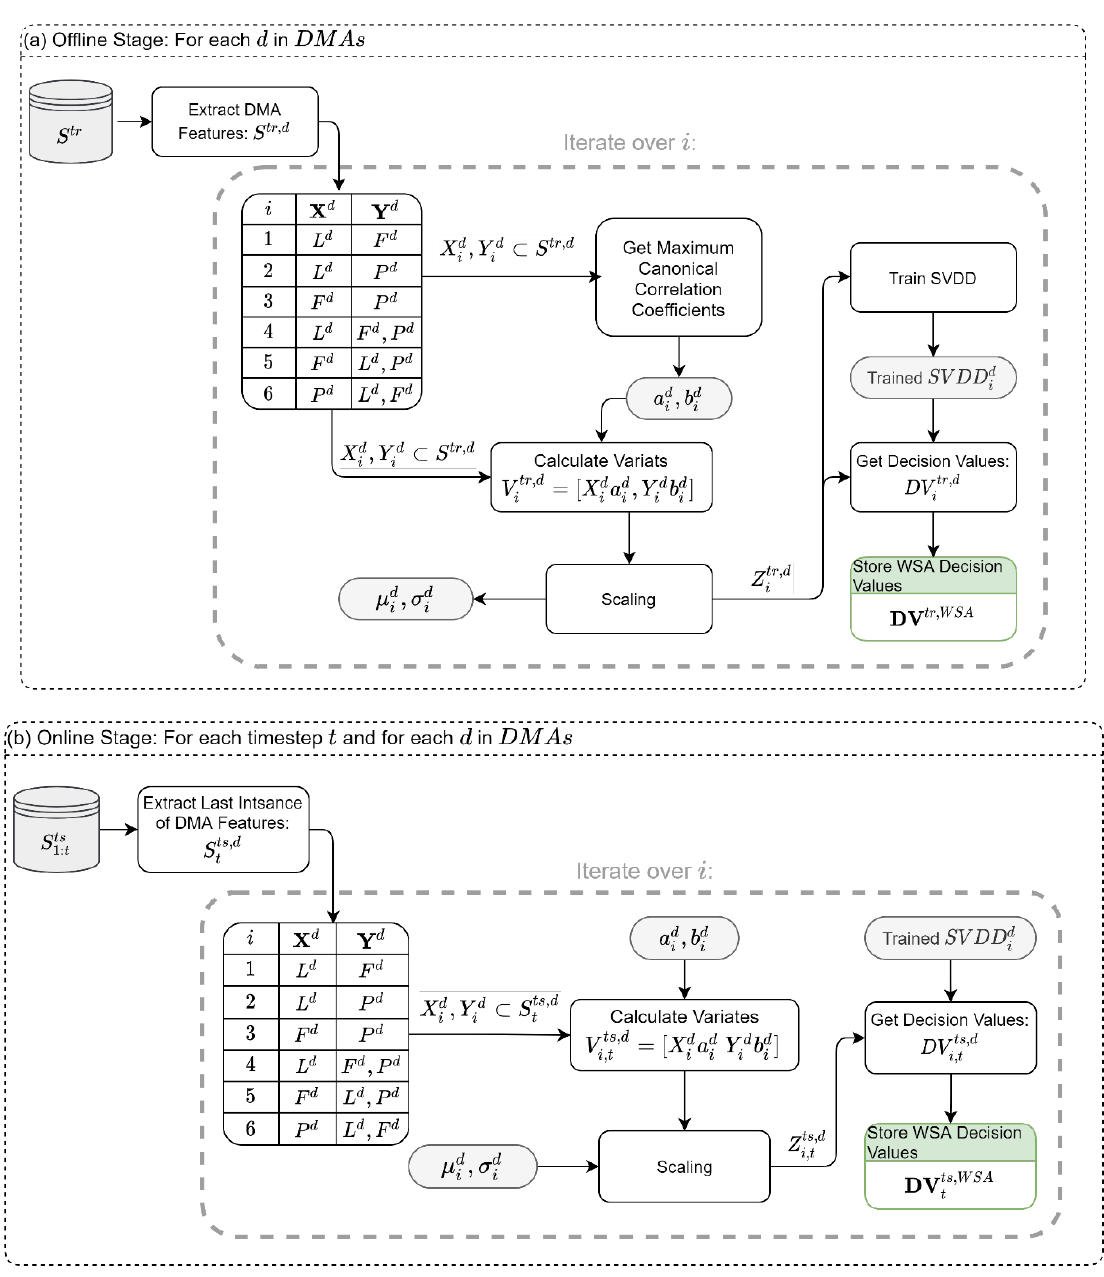
Figure 2. Within-DMA spatial analysis module: ( a ) Offline Stage, ( b ) Online stage. Notes: Gray shade is the data created in the Offline Stage and used in the Online Stage; green shade is the data used in the synthesis module.